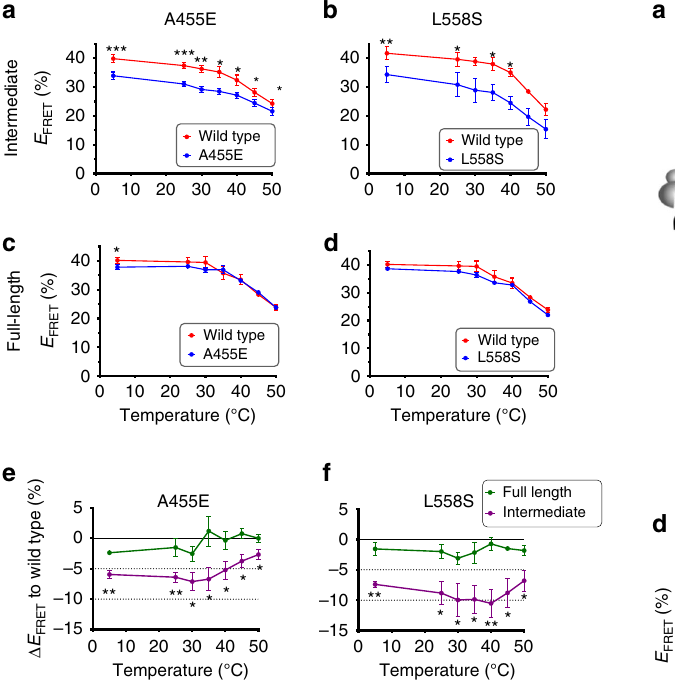
Fig. 4 Thermal stability of NBD1-folding intermediates. a - d Temperature- dependent FRET ef fi ciencies of wild-type (red line) and A455E or L558S (blue lines) ribosome-bound CFP-NBD1 polypeptides. Acceptor dye was located at Arg487 and polypeptides were truncated at residue 654 (intermediate) a , b or 744 (full-length) c , d . Data are mean ± SEM, n = 3 or 7 independent experiments. Two-tailed student ’ s t test, asterisk p < 0.05, double asterisk p < 0.01, triple asterisk p < 0.001, n.s. > 0.05 otherwise indicated. e , f Graphs show the difference between temperature-dependent FRET ef fi ciencies for wild-type and mutants calculated from a – d . One-tailed student ’ s t test, * p < 0.05, ** p < 0.01, n.s. > 0.05 otherwise indicated. Note that wild-type data at 45 °C in b – d , A455E data at 25, 40, 45, and 50 °C